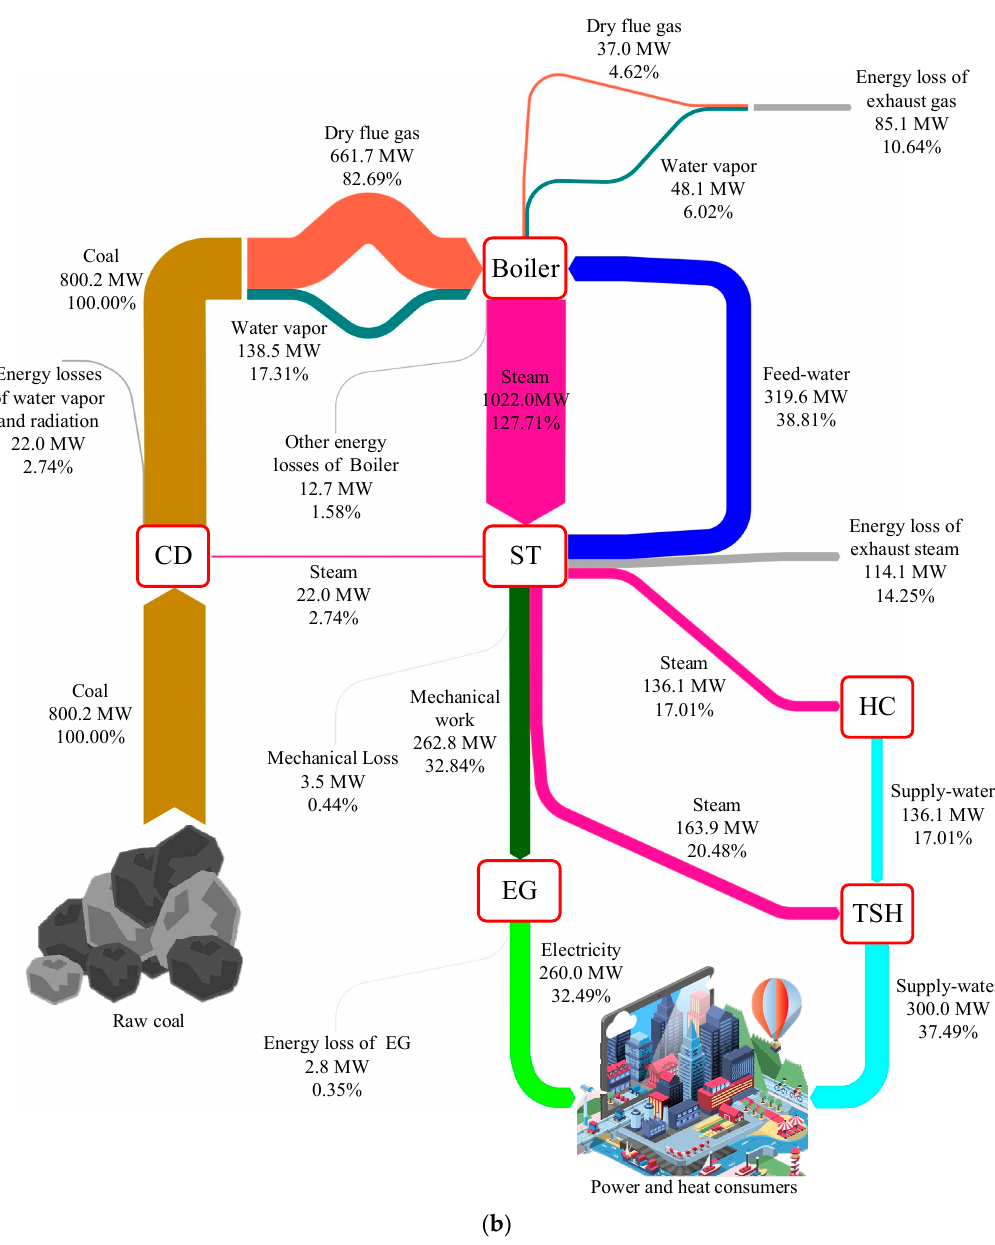
Figure 4. Diagram of the primary energy flows in the original HBP-CHP unit and proposed HBP-CHP unit: ( a ) Original unit; and ( b ) Proposed unit. unit: ( a ) Original unit; and ( b ) Proposed